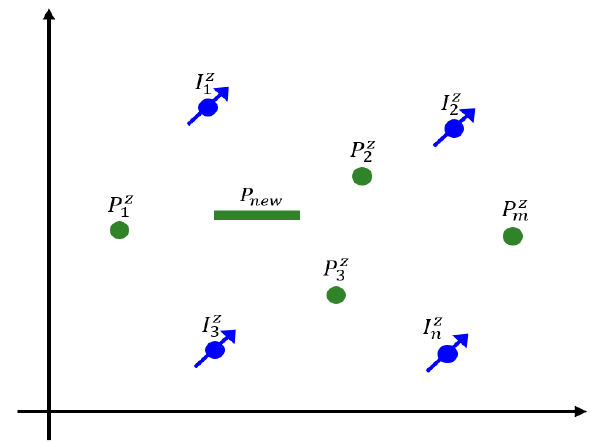
Figure 5. The mixed well pattern of multilateral-vertical wells.